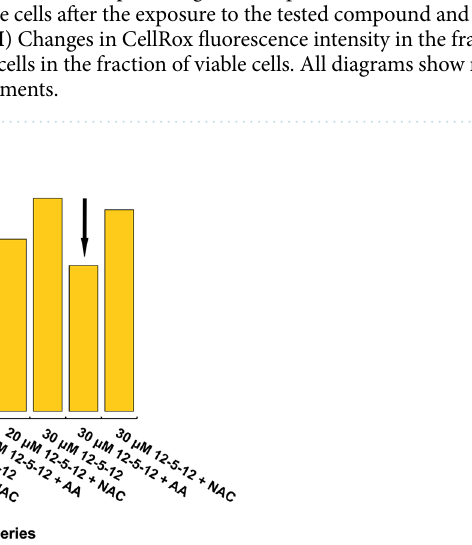
Figure 10. The effect of antioxidants on the number of dead cells. The percentage of dead cells was estimated after 72-h simultaneous exposition to various concentrations of the 12-5-12 and 50 μmol/L NAC or 200 μmol/L AA antioxidants. The columns represent data from a single